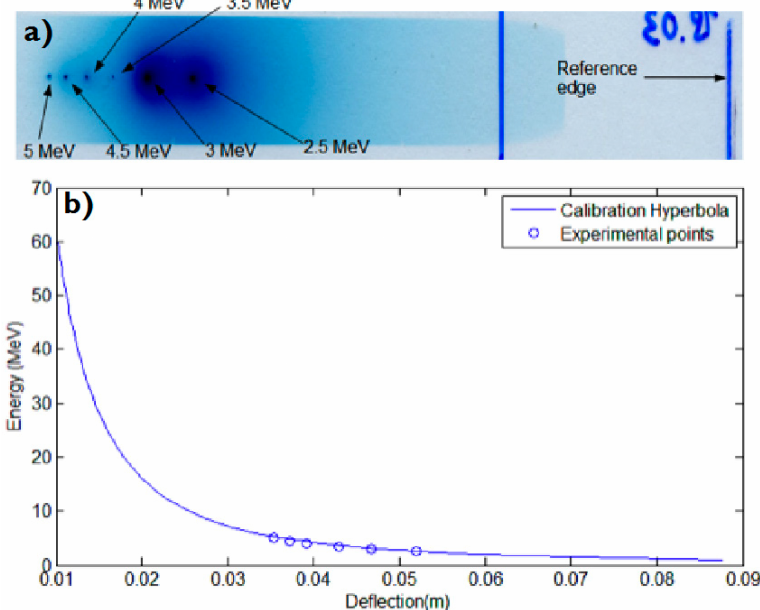
Figure 7. ( a ) Experimental measurements of the slit position as a function of the energy, using accelerator-driven proton beam in the energy range between 2.5 and 5 MeV and ( b ) comparison with the calibration Equation (1) of the energy selection system.